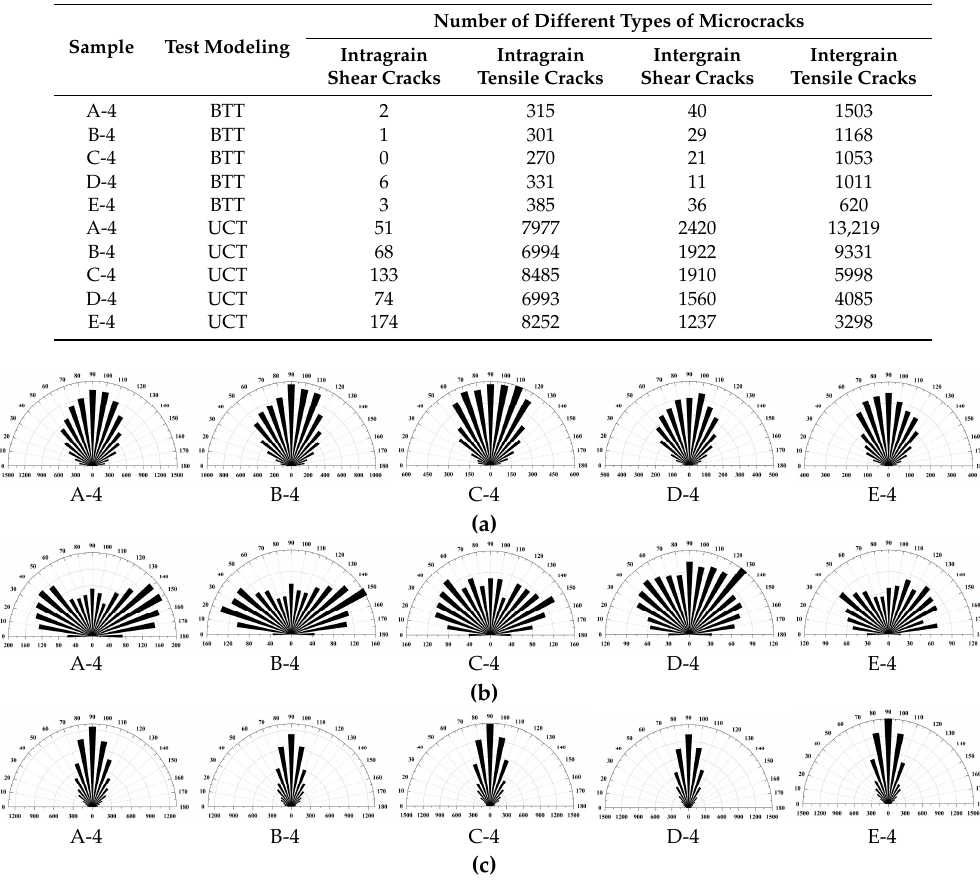
Figure 14. The rose diagrams of the inclination angle of different type microcracks in the corresponding models in Figure 13b. ( a ) The rose diagram of inclination angle of intergrain tensile microcracks; ( b ) The rose diagram of inclination angle of intergrain shear microcracks; ( c ) The rose diagram of inclination angle of intragrain tensile